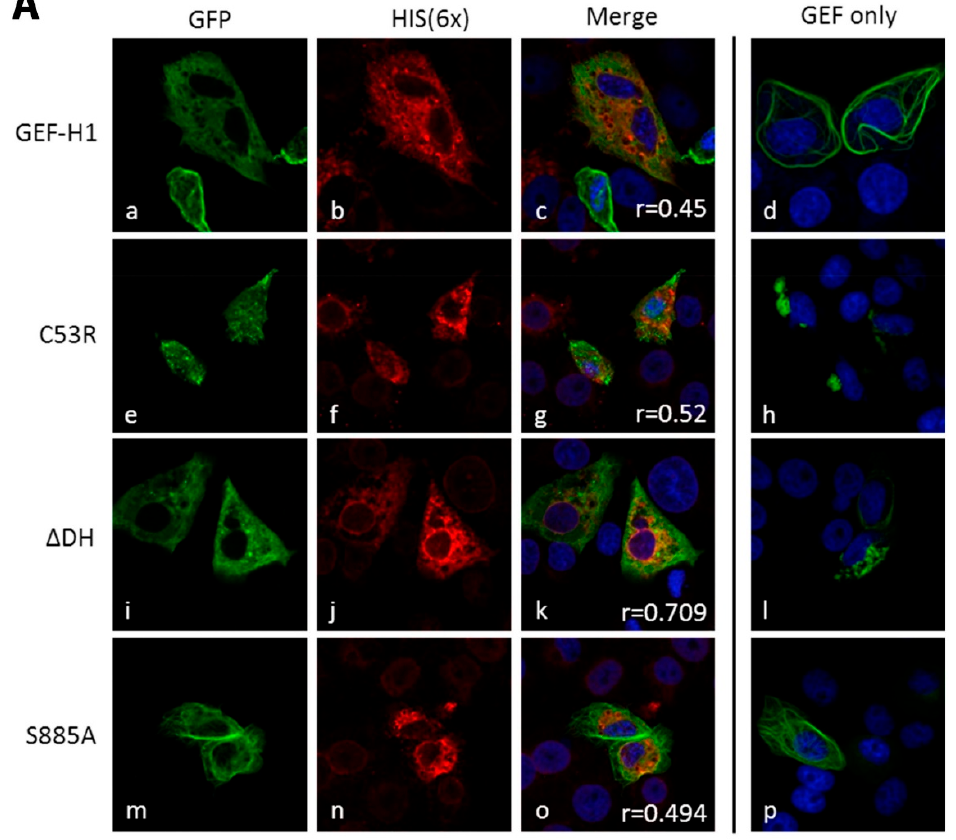
Figure 4. Expression of NS3 changes the location and morphology of the different GEF-H1 forms. ( A ) Vero cells were co-transfected with the HIS-tagged viral protein NS3 and the four different GEF-H1- GFP forms (WT, C53R, ∆ DH, S885A). The GFP signal of the different GEF-H1 forms is displayed in panels a, e, I, and m, while panels b, f, j, and n show the staining with the anti-6× HIS antibody. Panels c, g, k, and o show the merged image including the nuclear stain (DAPI). Panels d, h, l, and p represent the merged image of GEF-H1-GFP transfected but uninfected cells. Co-transfected cells displayed a dispersed morphology of GEF-H1 compared to cells transfected with the GEF-H1 forms only (panels d, h, l, and p). The co-localisation was quantified with the Pearson’s coefficient and is indicated in the merged image (panels c, g, k, and o). ( B ) Quantitation of the Pearson’s coefficients: C53R = 0.42 ± 0.19